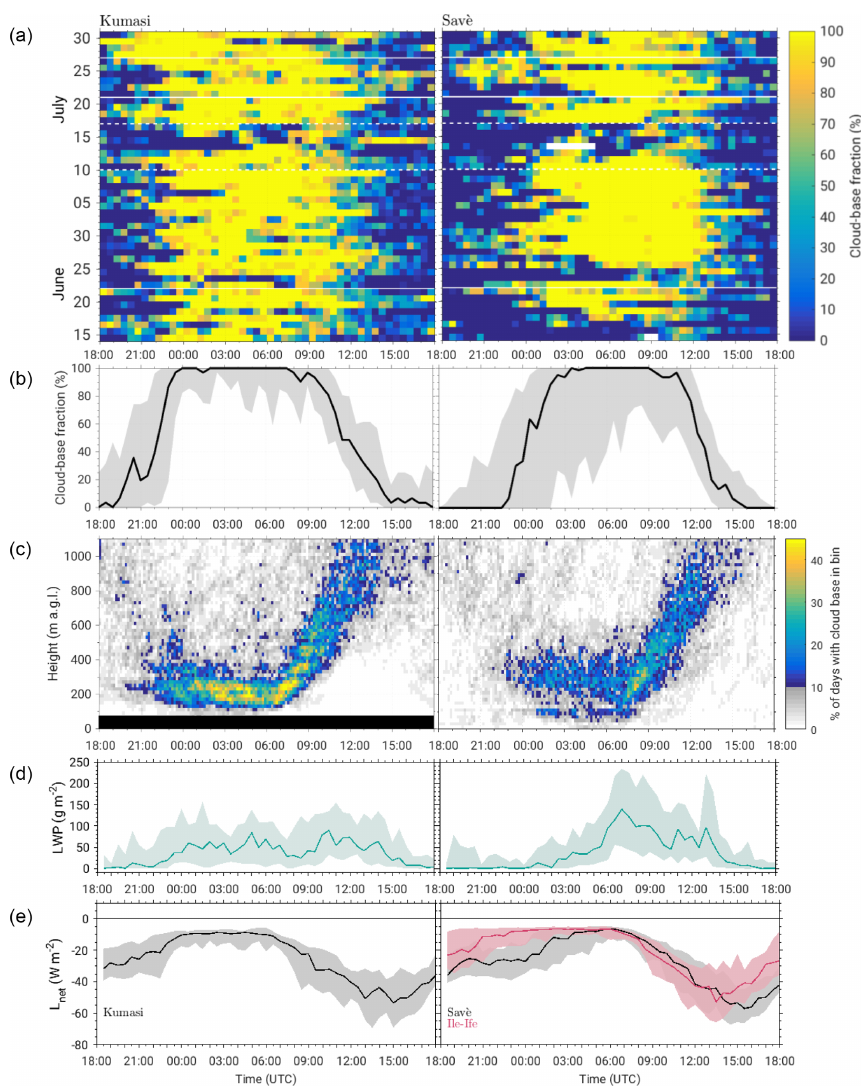
Figure 5. Daily resolved cloud-base fraction (a) and median (b) of clouds between 0 and 1000ma.g.l. Distribution of cloud-base height occurrence during the whole 48 days period for the Kumasi (left) and Savè (right) sites (c) . Cloud-base fraction and frequency distribution of cloud-base height are calculated from ceilometer data. White horizontal lines in (a) indicate different phases of the monsoon according to Knippertz et al. (2017). Median diurnal cycles of the liquid water path, LWP, from microwave radiometer (d) and net longwave radiation from surface measurements (e) . The shaded areas in corresponding colours represent interquartile